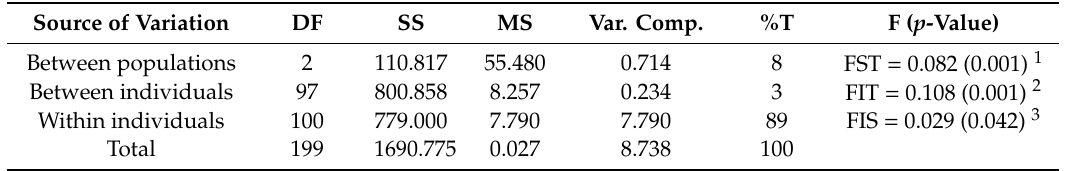
Table 3. Statistics of the analysis of molecular variance (AMOVA) using 25 microsatellite loci in three Brazilian Creole chicken